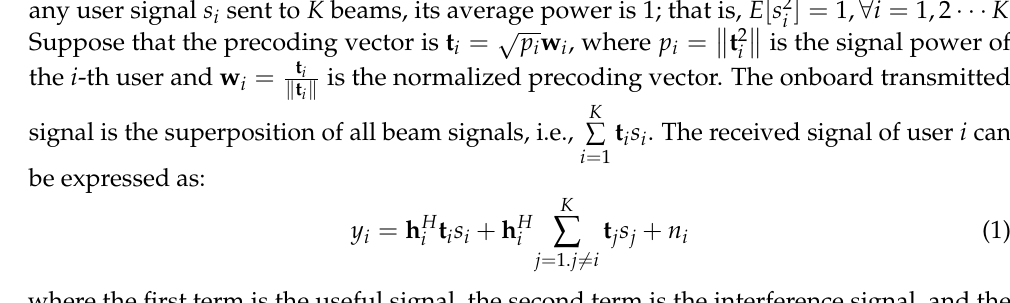
Figure 2. Schematic diagram of the forward link of a high-throughput satellite communication sys- tem.